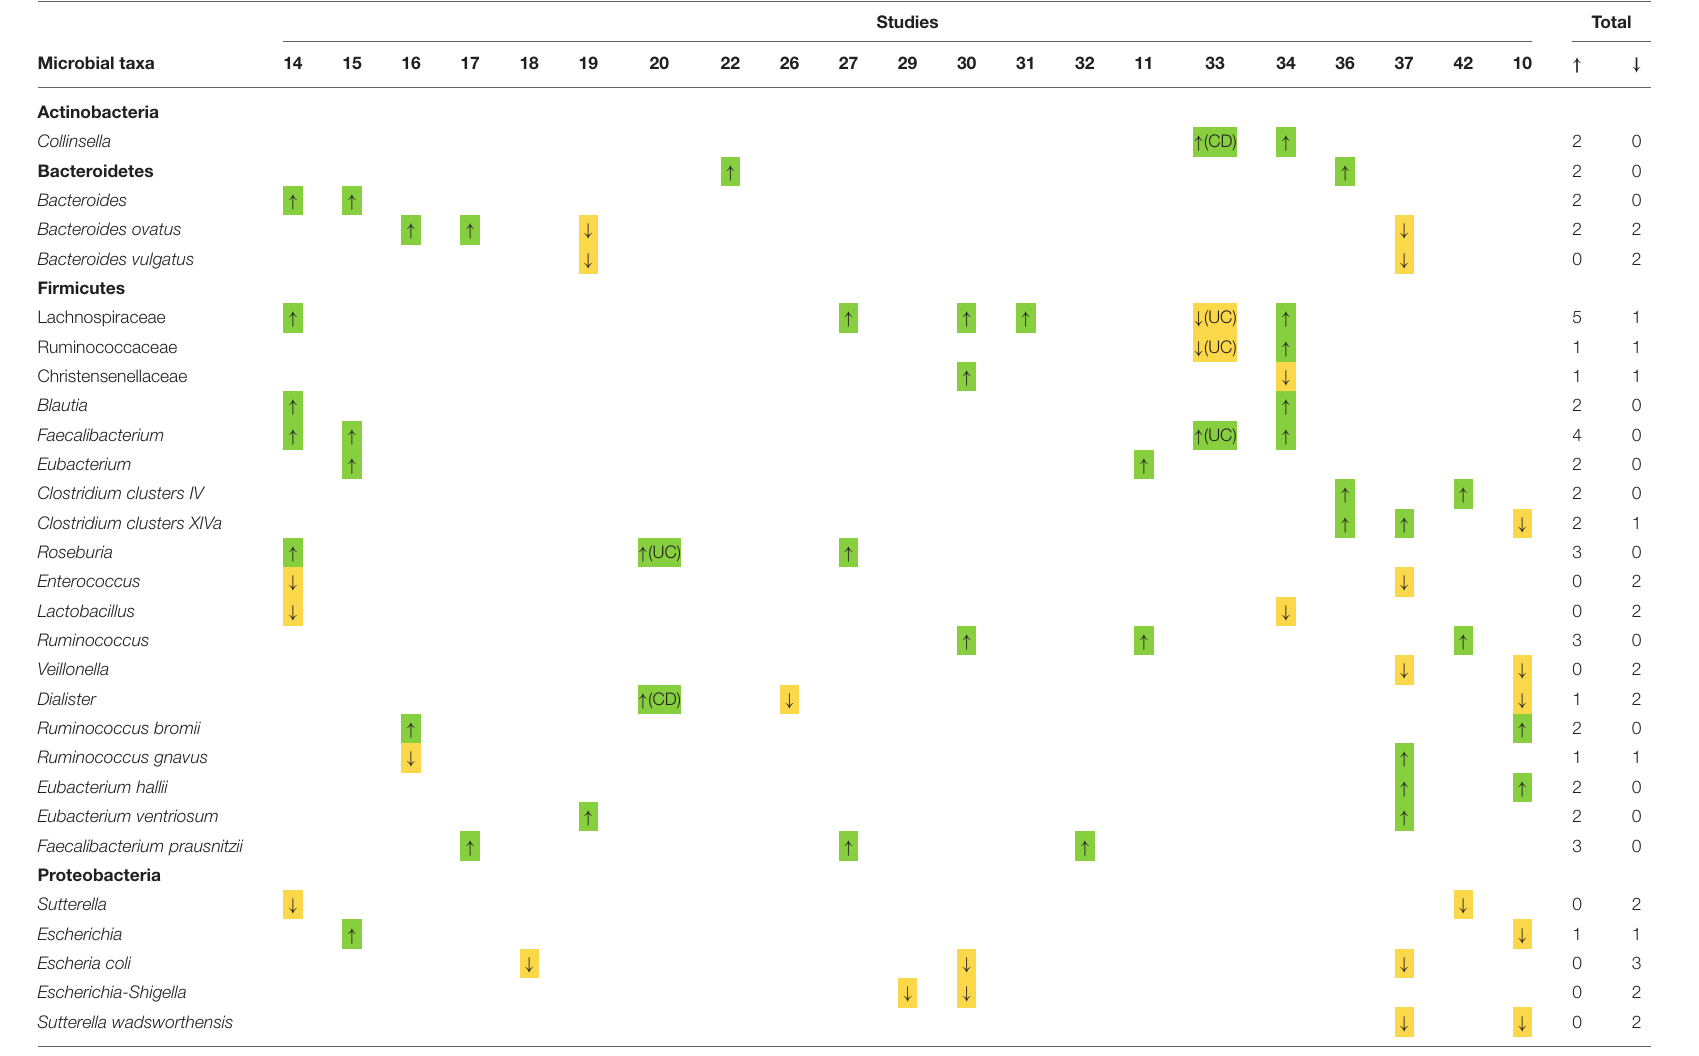
TABLE 4 | Microbial difference between responders and non-responders after FMT.